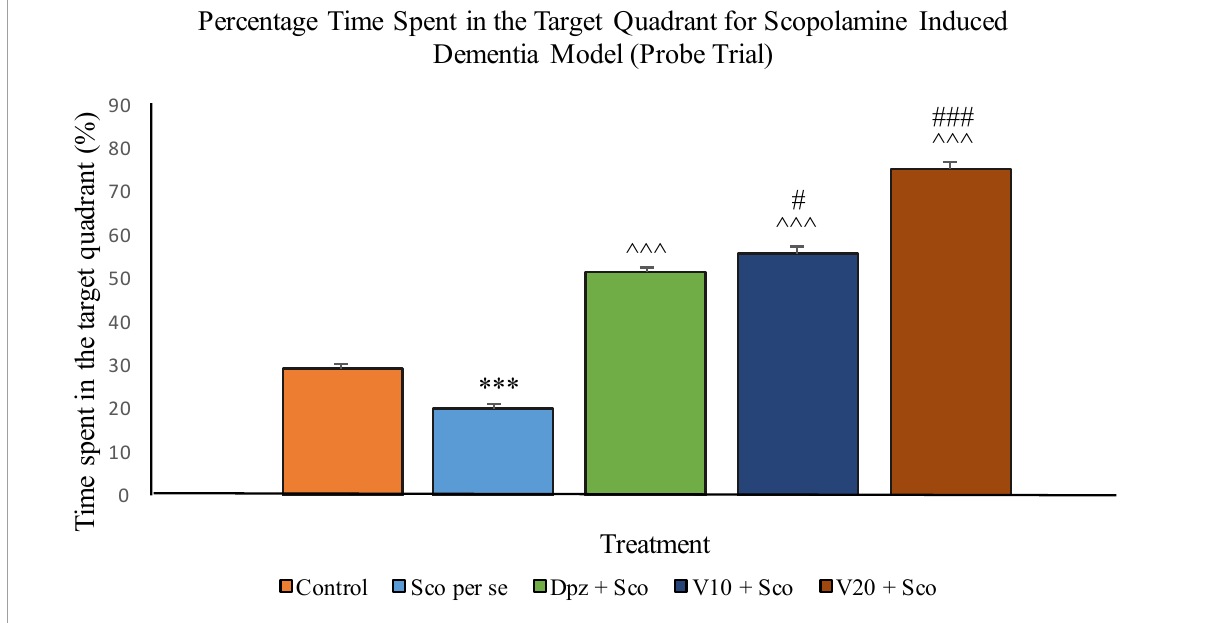
FIGURE17 Effect of vanillin and other treatments on percentage time spent in the target quadrant (probe trial). Data are expressed as mean ± SEM. “***” denotes P < 0.001 with respect to the control group within the probe trial. “###” denotes P < 0.001 with respect to the standard treatment group within the probe trial, and “#” denotes P < 0.05 with respect to the standard treatment group within the probe trial. “ ∧∧∧ ” denotes P < 0.001 with respect to the negative control (Sco per se ) group within the probe